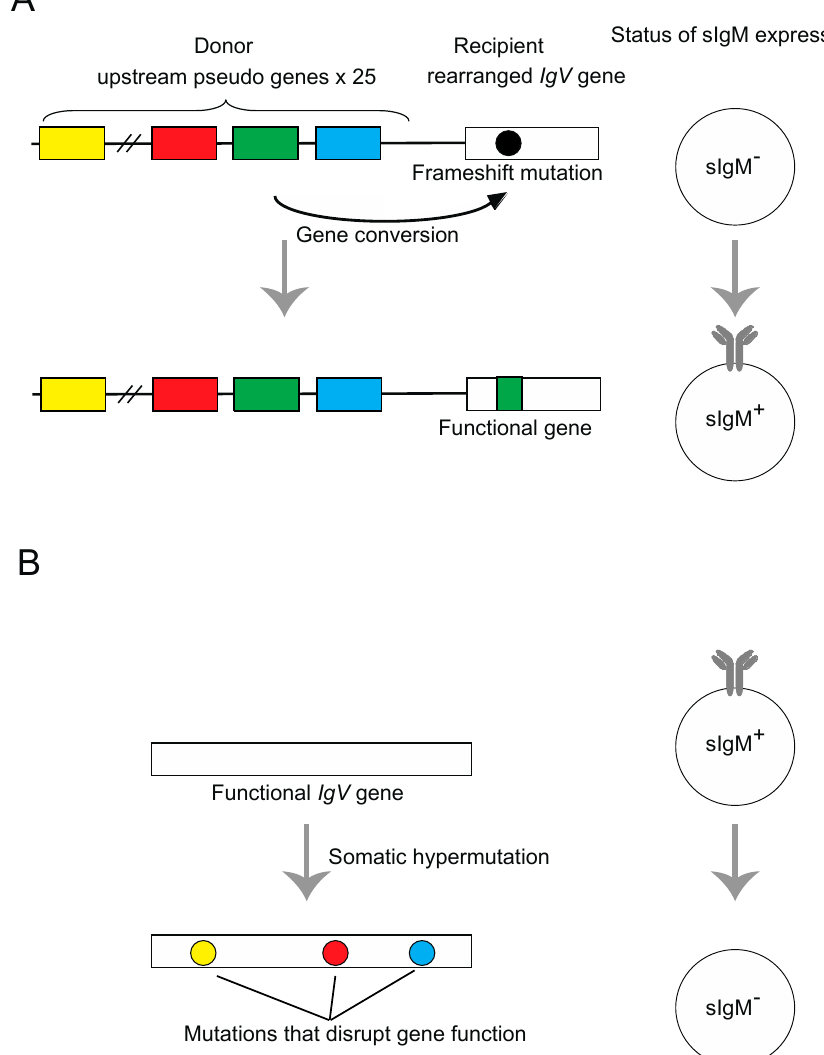
Figure 3. Schematic representations of the surface immunoglobulin M (sIgM) gain ( A ) and sIgM loss assays ( B ). ( A ) Principle of the Ig gene conversion assay. The sIgM-negative DT40 clone contains a frameshift in its rearranged V-J λ segments, which can be repaired by pseudogene-templated conversion events. The rate of Ig gene conversion can be measured as a gain of sIgM expression in subclones by flow-cytometric analysis of sIgM staining. ( B ) Principle of the Ig hypermutation assay. The DT40 cells carrying wild type IgV gene, which can be disrupted by somatic hypermutation events. The rate of hypermutation events can be measured as a loss of sIgM expression in subclones by flow-cytometric analysis of sIgM staining. The sequence analysis of hypermutation event can be also carried out by selecting sIgM negative cells by cell sorter.